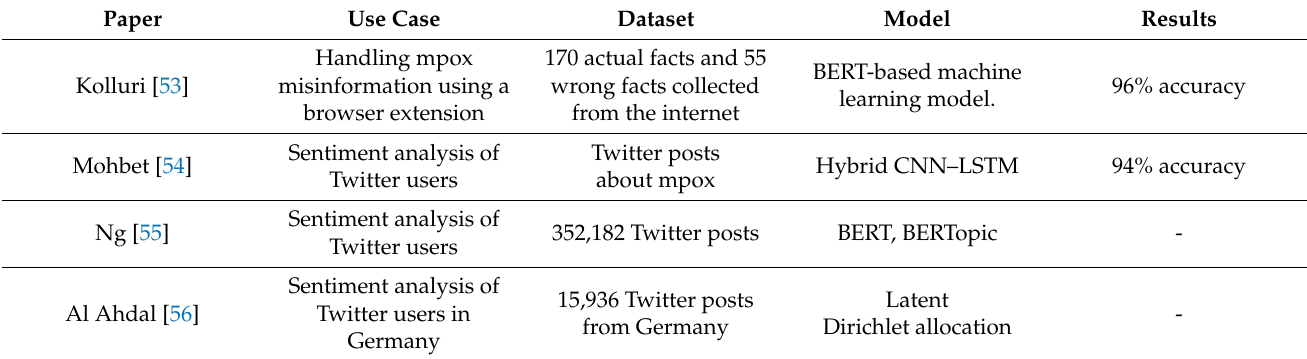
Table 3. Published artificial intelligence-based models for mpox-related web